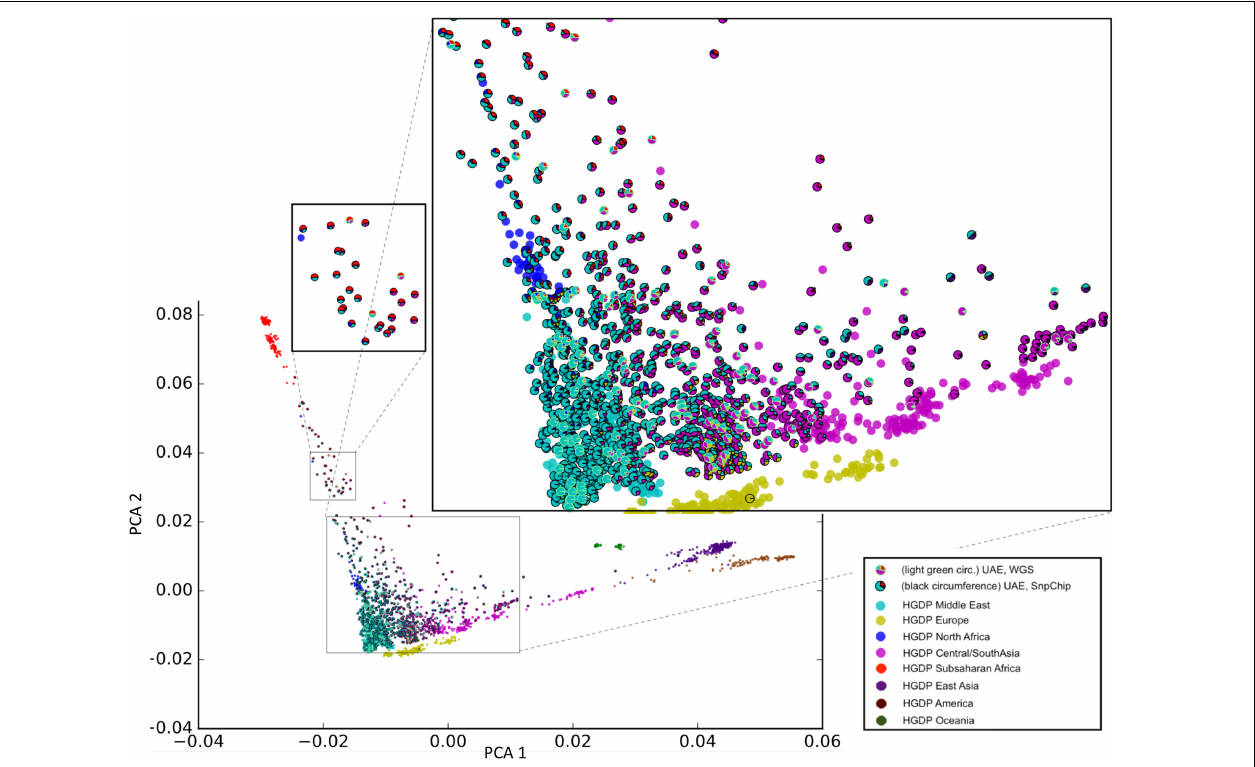
FIGURE 2 | Principal component analysis (PCA)/Admixture plot of 1,000 UAE nationals and 1,043 samples from the human genome diversity project (HGDP). From the phylogenetic tree of 1,000 genotype arrays, 120 UAE samples (predominantly cyan color with outline) were selected for whole genome sequencing. The admixture of UAE samples is shown as pie charts, with sector coloring consistent with HGDP population colors. The zoomed-in views display the genetic diversity of the UAE population with admixtures predominated by Middle Eastern, Central/South Asia (large zoomed inset), and Sub-Saharan Africa (small zoomed